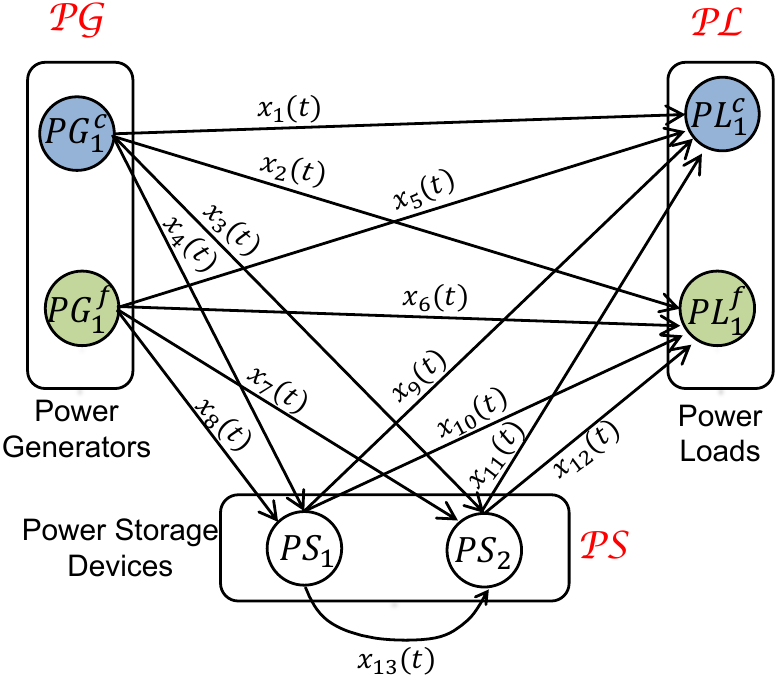
Figure 5. An overview of a simple power flow system. In spite of the notational rule on x , an integral label instead of the pair of device names is used for